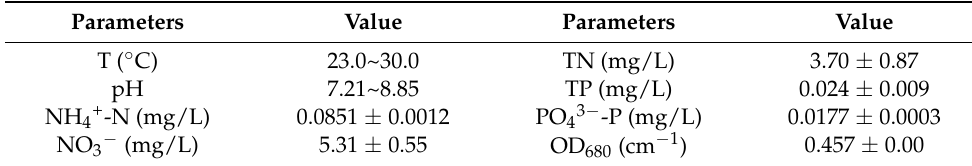
Table 1. Water quality